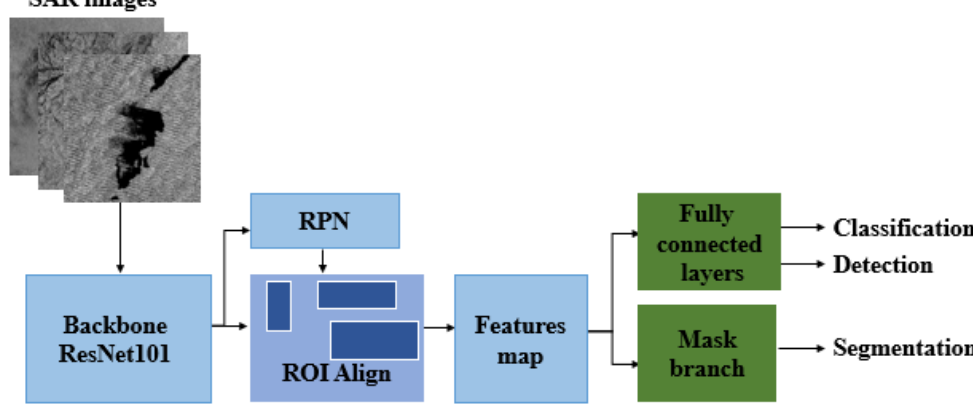
Figure 3. Mask R-CNN architecture. RPN stands for region Proposal Network, ROI stands for Region Of